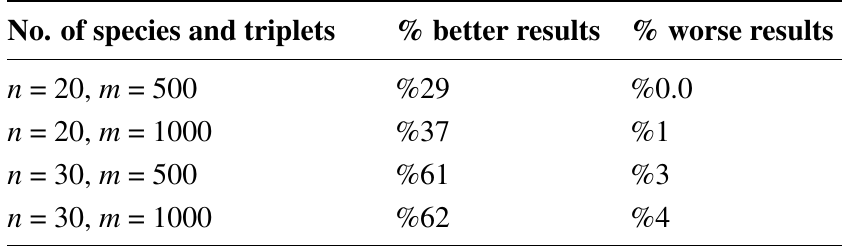
Table 2. Performance results of Best Pair Merge with Total Reconstruction (BPMTR) in comparison to Best Pair Merge with Reconstruction